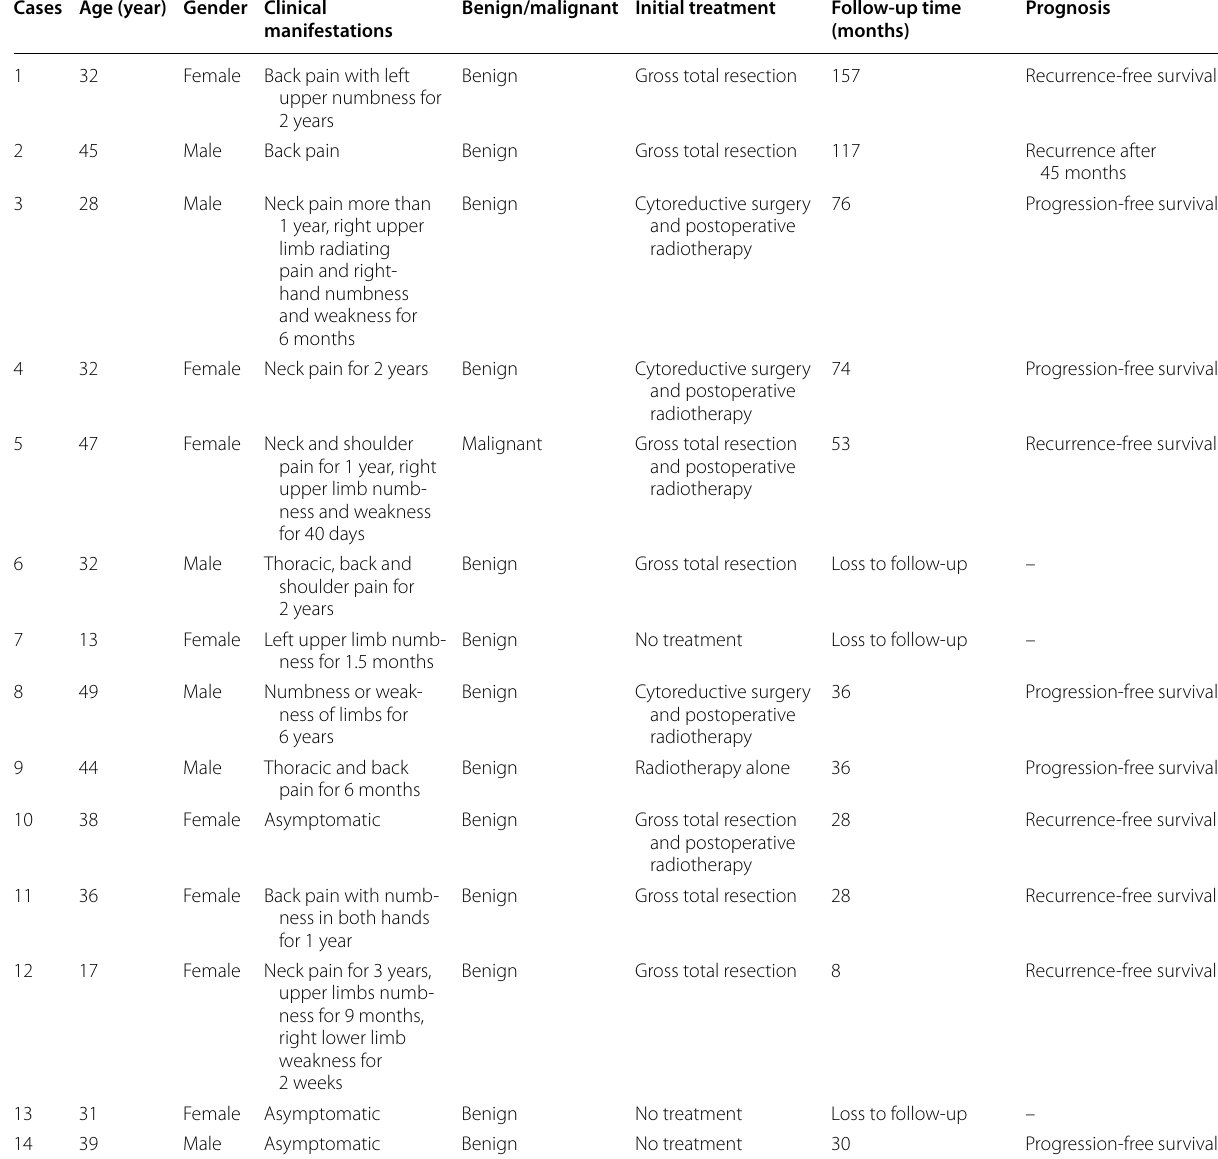
Table 1 General information of the 14 patients with spinal giant cell tumour of the tendon sheath (GCTTS) Cases Age (year) Gender Clinical